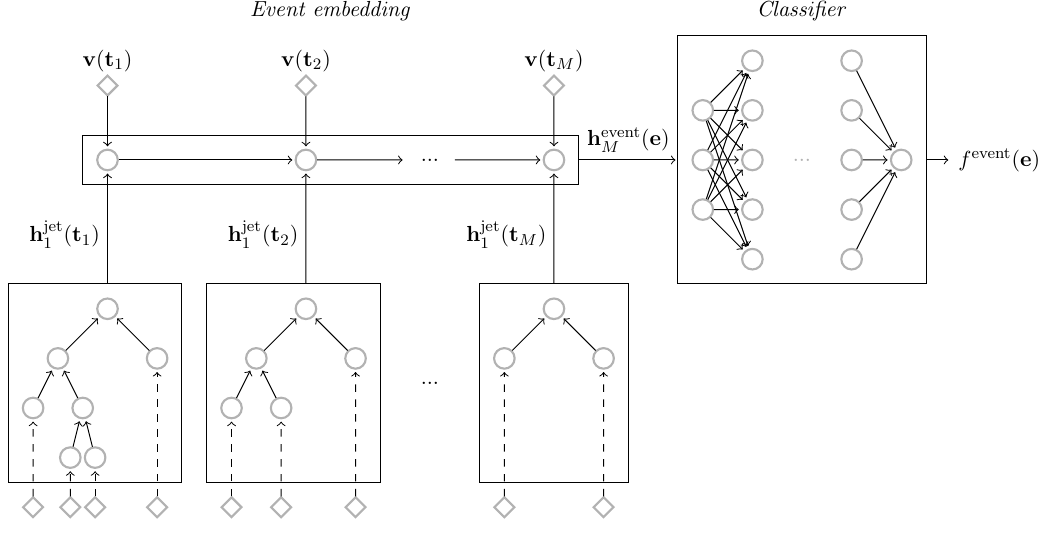
Figure 2 . QCD-motivated event embedding for classi(cid:12)cation. The embedding of an event is computed by feeding the sequence of pairs ( v ( t j ) ; h jet ( t j )) over the jets it is made of, where v ( t j ) 1 is the unprocessed 4-momentum of the jet t j and h jet ( t j ) is its embedding. The resulting event- 1 level embedding h event ( e ) is chained to a subsequent classi(cid:12)er, as illustrated in the right part of M the